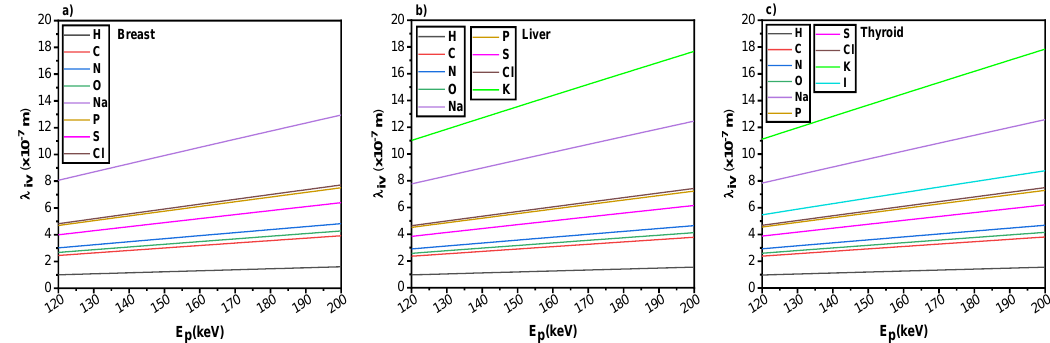
Figure 6: Inelastic valence mean free path as a function of positron energy for (a) breast, (b) liver, and (c)